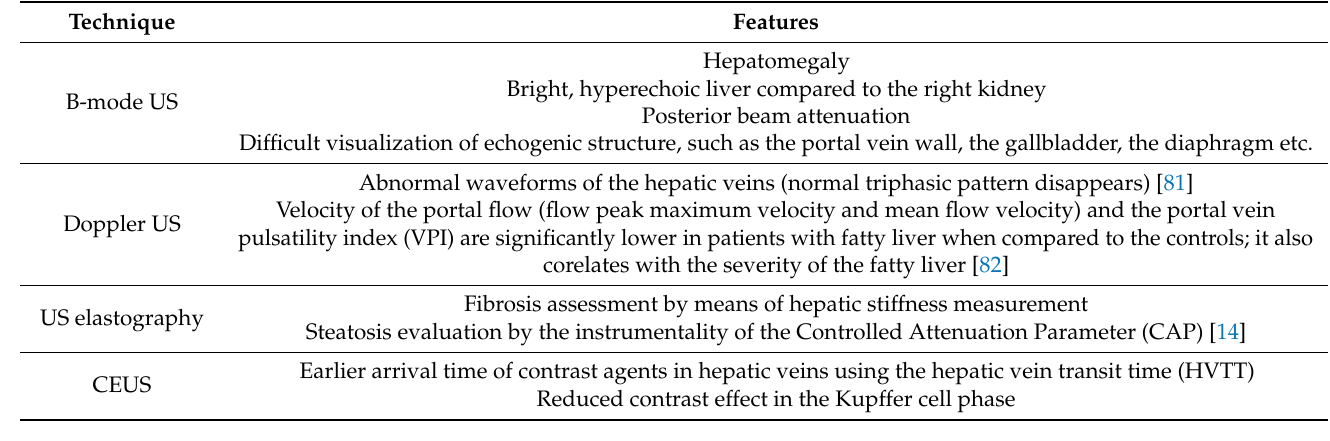
Table 3. Characteristic of NAFLD by different non-invasive